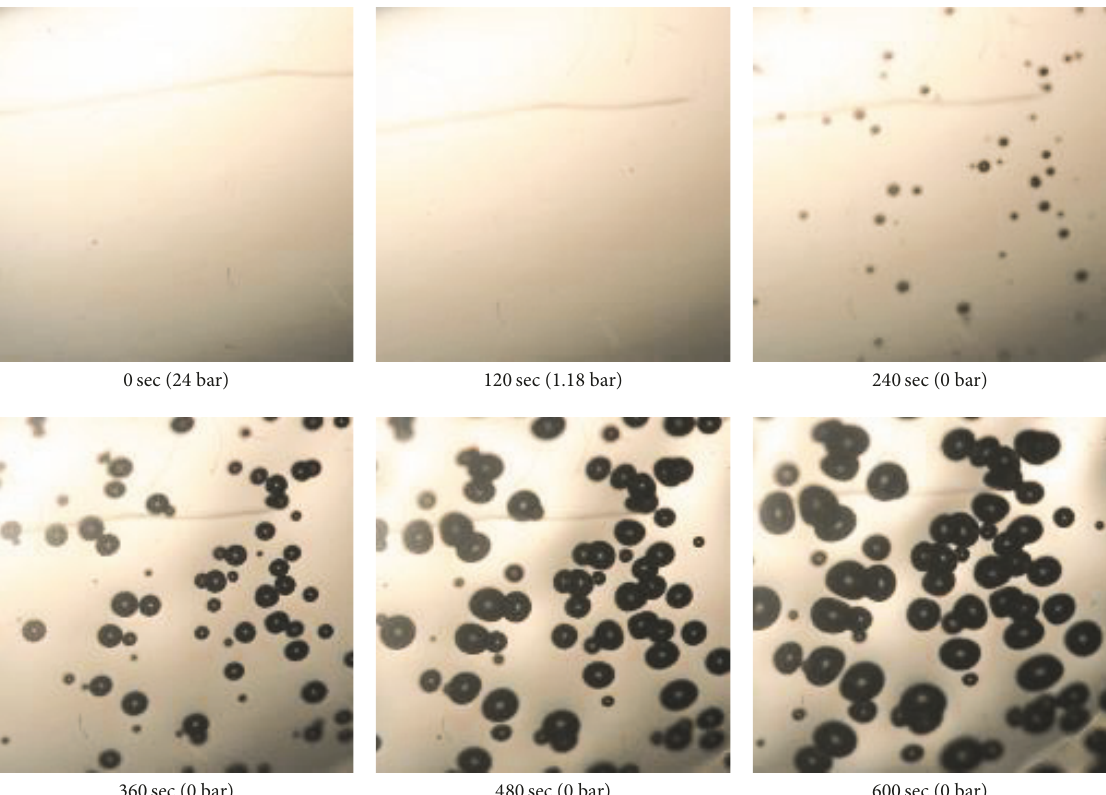
Figure 8: Photographs of a 1mm thick PS sample at various times after the onset of depressurization after holding at 24 bar (in CO 2 ) and 100 ∘ C for 2 hours (scale of images is 6 × 6